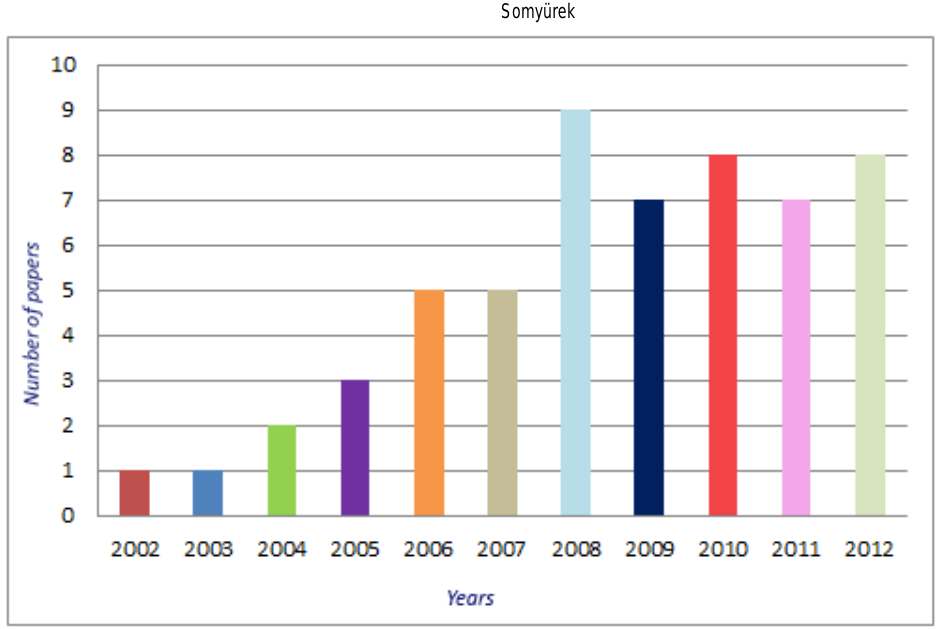
Figure 1. The number of reviewed papers by